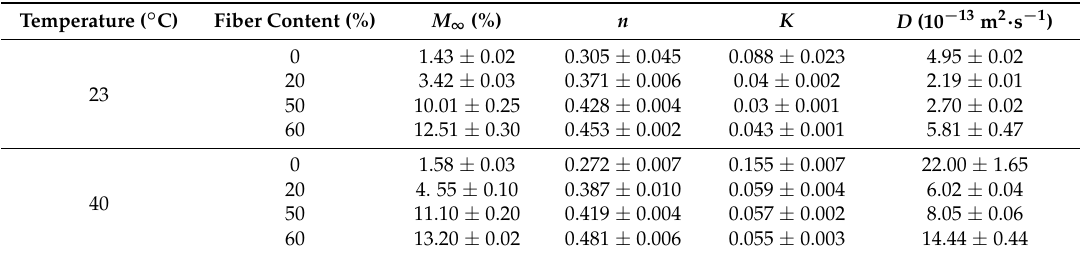
Table 3. Fick’s parameters and diffusion coefficient at 23 and 40 ◦ C regarding the fiber content. Temperature ( ◦